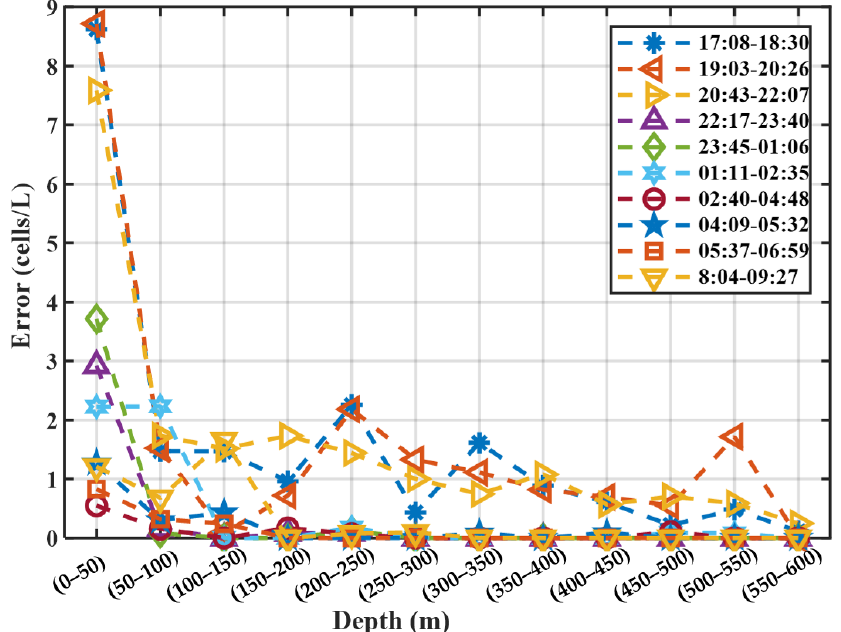
Figure 12. Statistical error in the estimation of the suspended particle concentration versus depth based on the holographic images taken from different profiles with the DHUG. The time is local time UTC+8